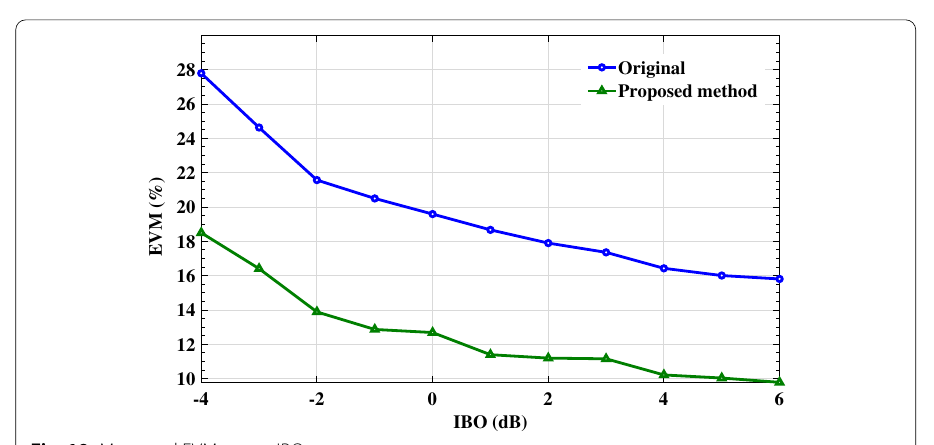
Fig. 19 Measured EVM versus